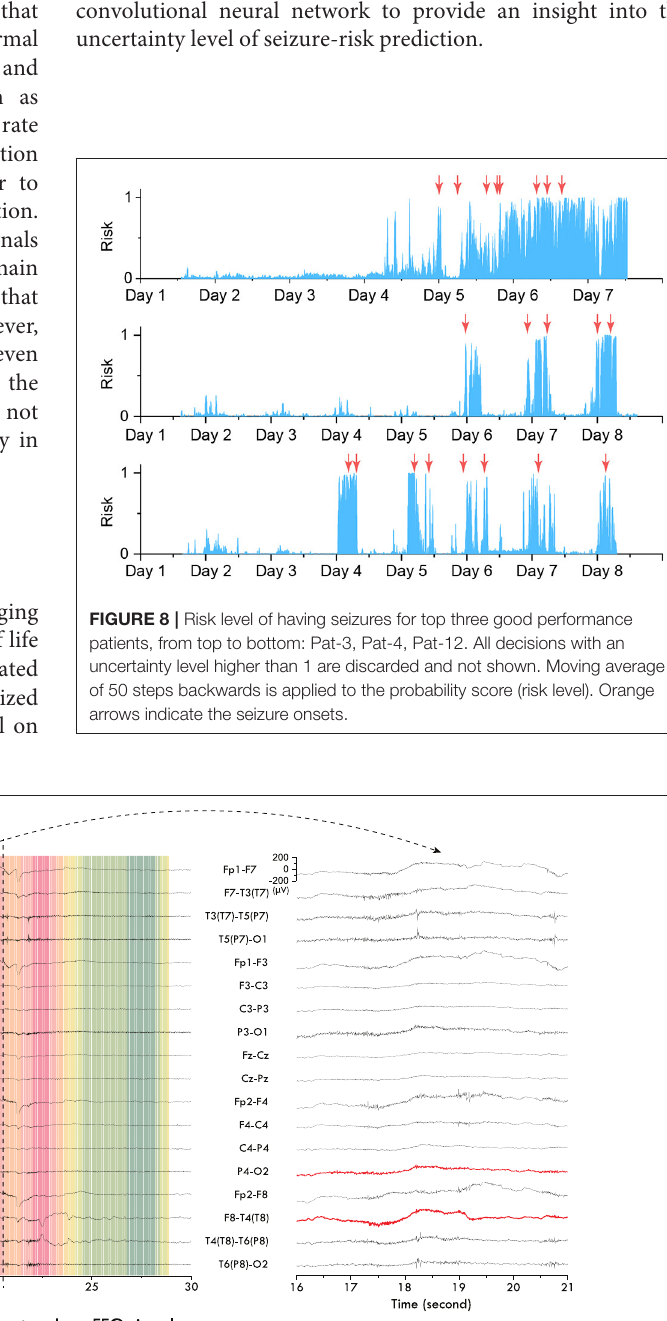
Frontiers in Neurology |